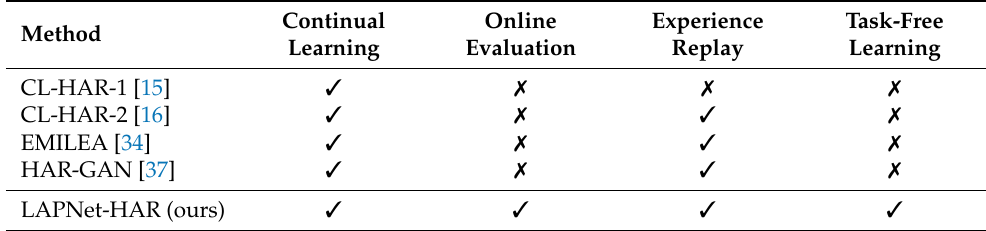
Table 1. Comparison of past CL paradigms applied to the HAR domain vs. our approach. Method